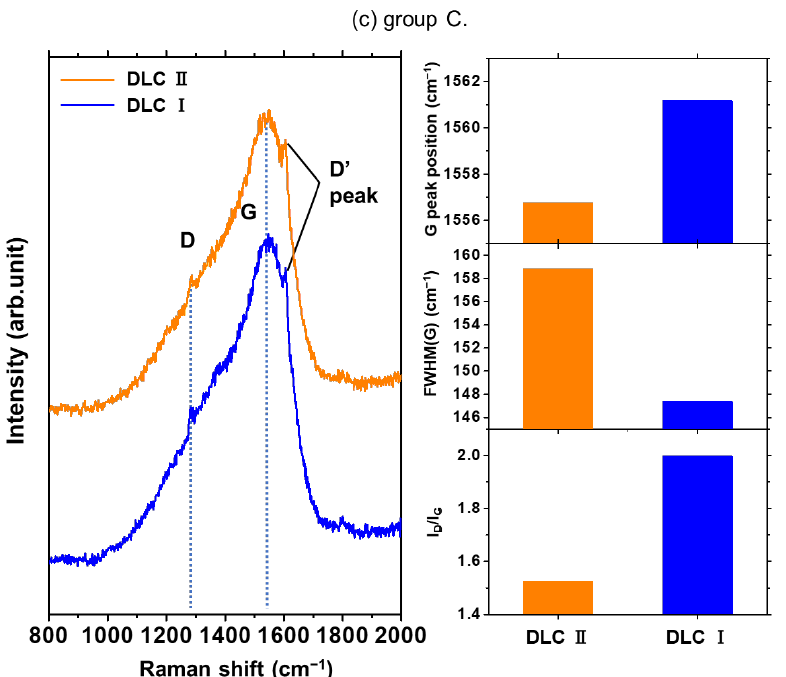
Figure 6. ( a ) Raman spectra and Raman parameters of the DLC I films for the samples in group A. ( b ) Raman spectra and Raman parameters for DLC/Cu(X)/DLC in group B. ( c ) Raman spectra and Raman parameters of the DLC I and II films, after peeling, for the samples in group C.